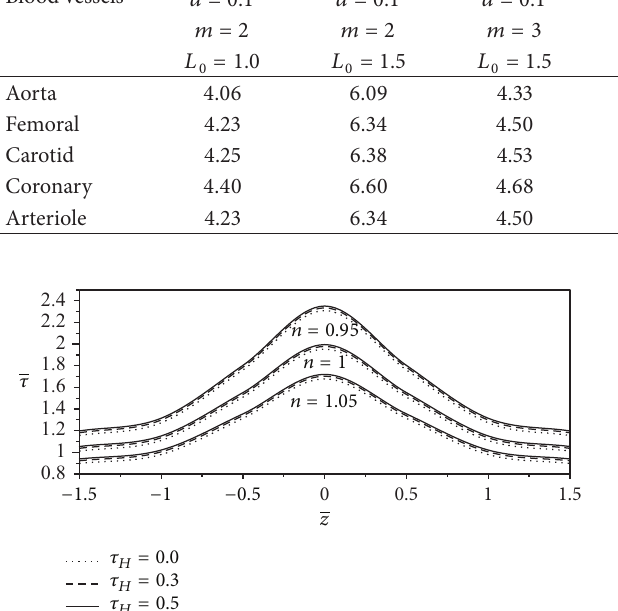
Figure 16: Variations of skin friction with axial distance for different values of power index and yield stress 𝜏 𝐻 .